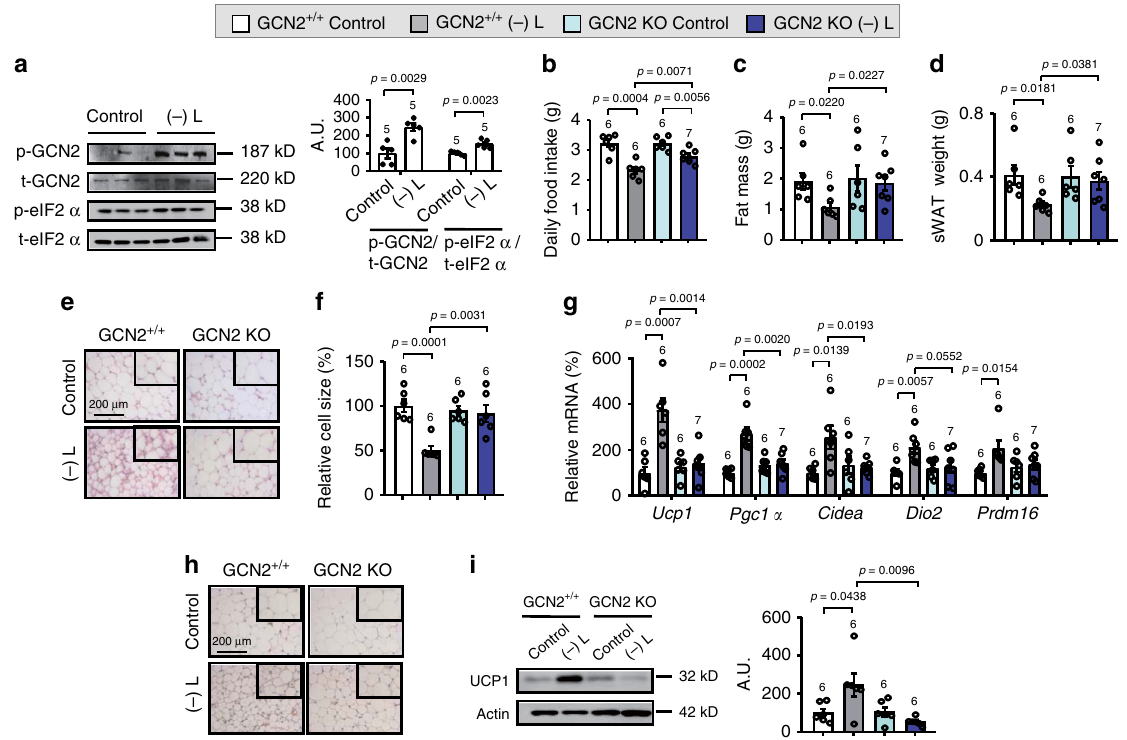
Fig. 3 GCN2 deletion in amygdala markedly blunts leucine deprivation-induced WAT browning. a P-GCN2, t-GCN2, p-eIF2 α , and t-eIF2 α proteins in amygdala by western blotting (left) and quanti fi ed by densitometric analysis (right); A.U.: arbitrary units. b Daily food intake. c Fat mass by NMR. d Subcutaneous WAT (sWAT) weight. e Representative images of hematoxylin and eosin (H&E) staining of sWAT. f sWAT cell size quanti fi ed by Image J analysis of H&E images. g Gene expression of Ucp1, Pgc1a, Cidea, Dio2 , and Prdm16 in sWAT by RT-PCR. h Representative images of immunohistochemistry (IHC) staining of UCP1 in sWAT. i UCP1 protein in sWAT by western blotting (left) and quanti fi ed by densitometric analysis (right). All studies were conducted using 20- to 22-week-old male control mice (GCN2 + / + ) or mice with GCN2 deletion in amygdala (GCN2 KO) fed a control (Control) or leucine-de fi cient [(-) L] diet for 3 days. Data are expressed as the mean ± SEM ( n represents number of samples and are indicated above the bar graph), with individual data points. Data were analyzed by two-tailed unpaired Student ’ s t test for ( a ), or by one-way ANOVA followed by the SNK (Student – Newman – Keuls) test for ( b – i ). Source data are provided as a Source data fi